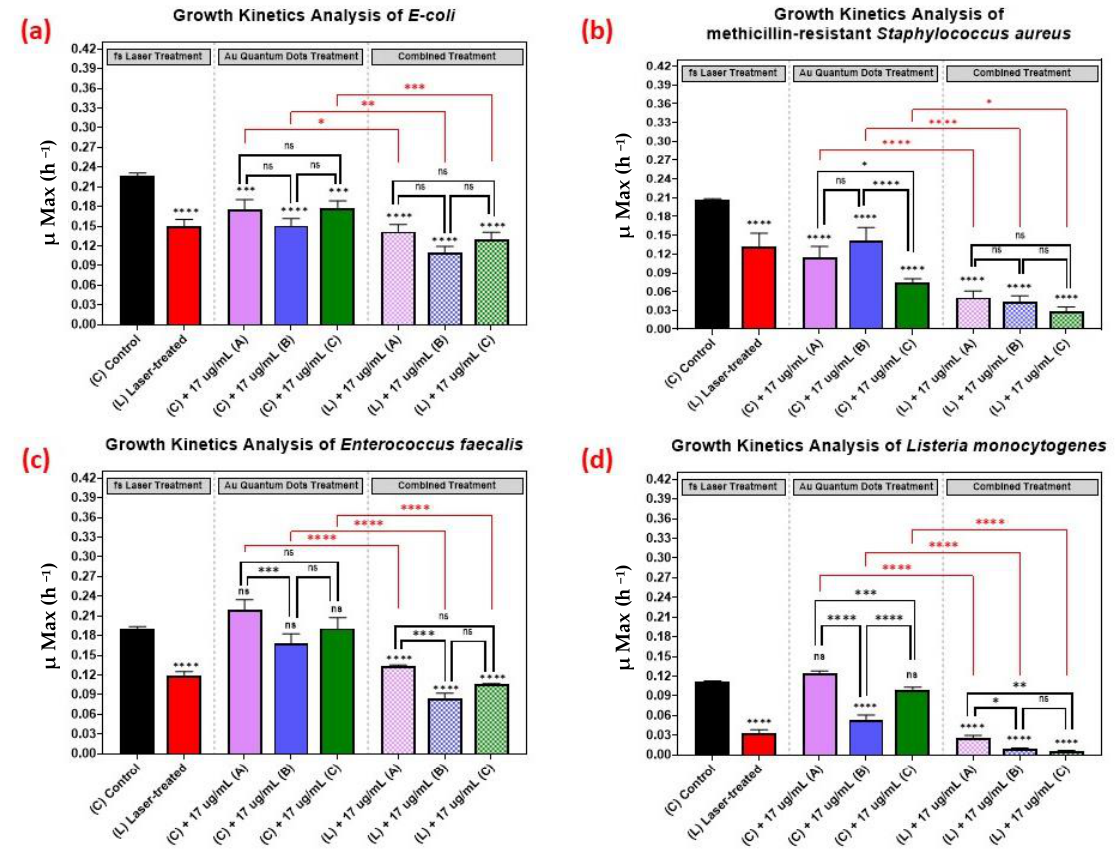
Figure 5. Bar graph of the four different bacterial pathogens: ( a ) E. coli , ( b ) Staphylococcus aureus , ( c ) Enterococcus faecalis , and ( d ) Listeria monocytogenes, comparing growth rate during the log phase of the control culture (C) with that of the bacterial cultures exposed to different treatments: laser treat- ment (L), AuQDs treatment (C + A, B, or C), and laser + AuQDs treatment (L + A, B, or C) . All four pathogens were exposed to femtosecond laser treatment using a wavelength of 400 nm and average power of 50 mW for 15 min. The cultures were exposed to three samples of AuQDs: sample (A) (7.8 nm average size), sample (B) (8.7 nm average size) and sample (C) (11.6 nm average size) at the same concentration of 17 µg/mL. Significance was tested by ANOVA followed by Tukey testing (**** p < 0.0001, *** p < 0.001, ** p < 0.01, * p < 0.05, ns; no significance). 3.4. Effect of Nanoparticle Concentration on the Growth Kinetics of the Microbial Pathogens Figure 6 shows the kinetic growth analyses of those pathogens treated with various concentrations of AuQDs: 55, 33, and 17 µg/mL. For Listeria monocytogenes , the effect of increasing the concentration was vivid, but not so with the other bacteria (Figure 6). This observation highlights the fact that it is not always optimal to increase concentration. In some cases, a lower AuQD concentration may be sufficiently antimicrobial, depending on the bacterium. Moreover, increasing the concentration in such cases may compromise safety and biocompatibility. This finding suggests a need to pay attention to the physico- chemical properties of the applied AuQDs as well as the treatment strategy.